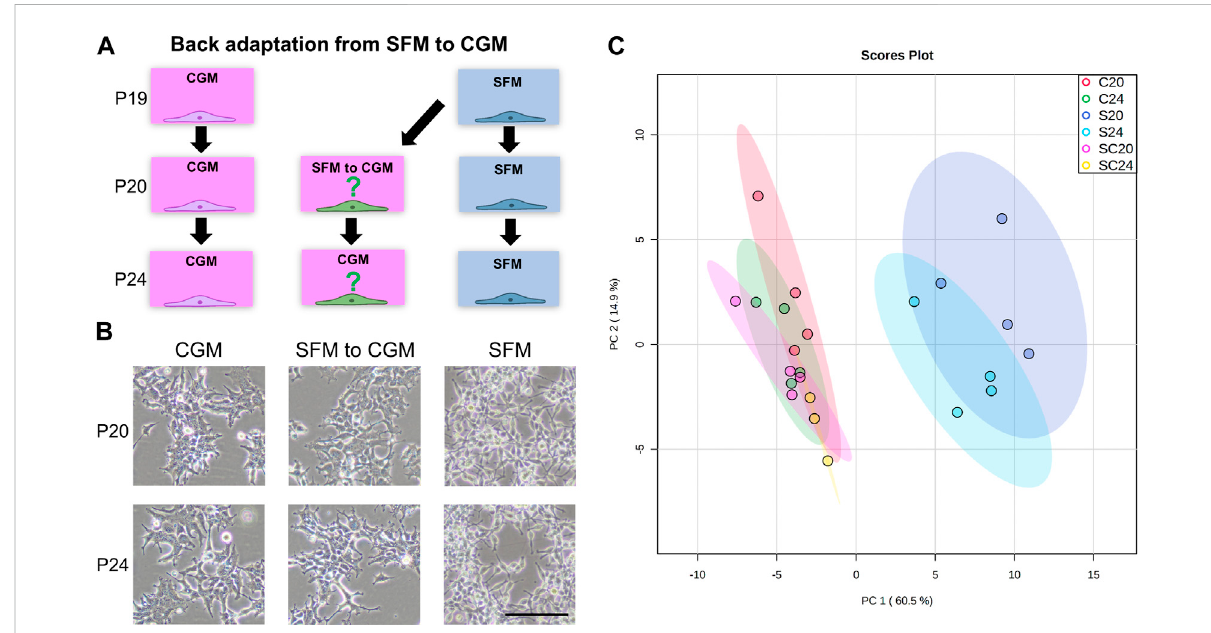
FIGURE 7 (A) Back adaptation procedure from SFM (serum-free medium, Freestyle293) to CGM (control growth medium, MEM+10% FBS). Passage 19 of HEK293cells(FullySFM-adaptedadherentcells)wasinitiatedforthebackadaptation.Early(afteronesubculture,passagenumber20,P20)andlate- stage(after5timessubcultureinCGM,passagenumber24,P24)ofbackadaptationweremonitored,andthesamepassagenumberofHEK293 cells cultured in CGM and SFM were also prepared in parallel. (B) Representative bright- fi eld images were shown to observe cell morphology after 48 hofcultivation.Thescalebarindicates100 µm. (C) 2DscoreplotofPCAanalysisofwholemetabolomesetsof6differentgroupswasshown.C,S, and SC indicate CGM, SFM, and SFM to CGM culture, respectively. The color ellipse in the score plot illustrates the 95% con fi dence